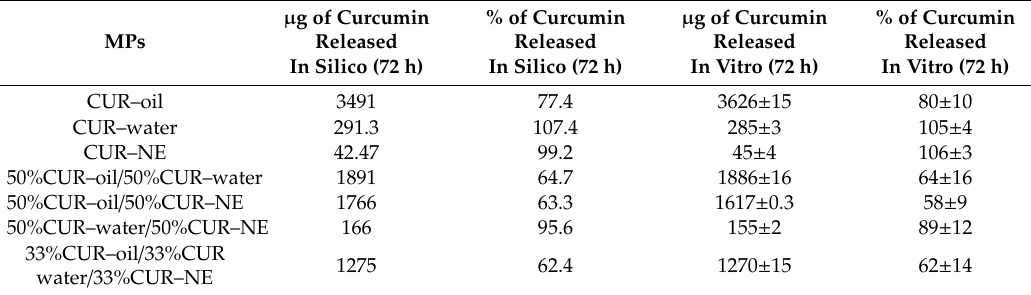
Figure 6. Correlation of curcumin released from different MP combinations: ( A ) experimental in vitro release, in PBS at pH 7.2, 550 rpm and 37 ◦ C and ( B ) in silico release. Table 2. In silico and in vitro curcumin release experiments ( n =